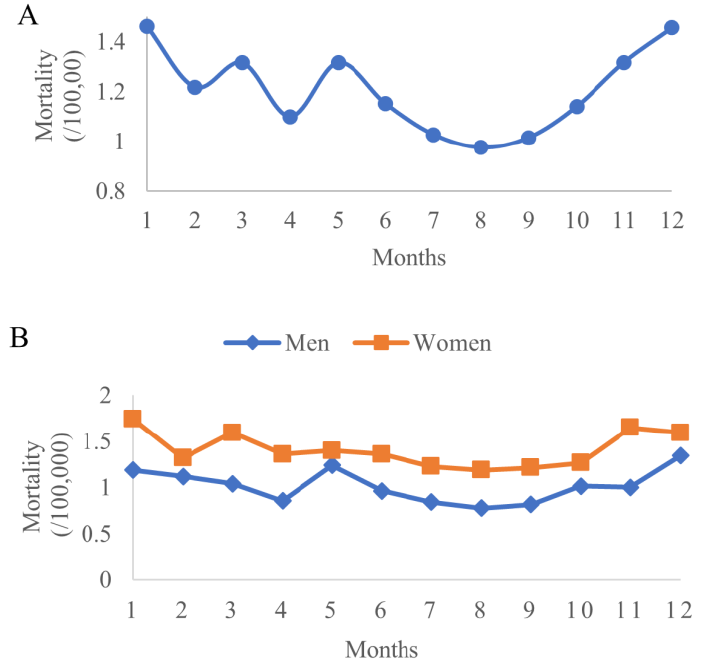
Figure 7. Average diabetes mortality rate in 31 surveillance points by months: total ( A ), by gender ( B ). However, regarding the difference between summer and winter at the county/district level, the patterns were different in the absolute rates. Although the eastern region remained as a high-rate area for both genders in winter (Figure S1), the western region experienced an increase from summer to winter (Figure S2). There were even lower mortalities in winter than in summer in some eastern counties for men (Figure 8).